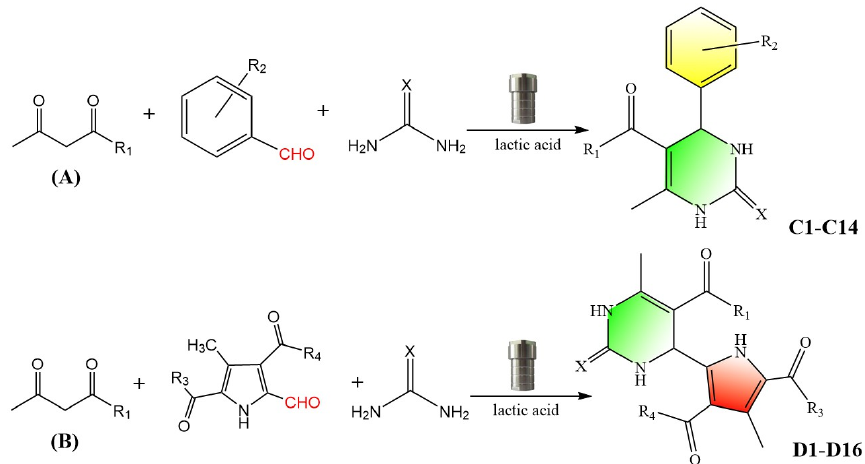
Scheme 2. Structural diversity in the DHPM scaffolds was generated by employing nine 1,3- dicarbonyl compounds, nine benzaldehyde derivatives and urea/thiourea. ( A ) Route for solvother- mal synthesis of dihydropyrimidinones containing a benzene ring ( C1 – C14 ). ( B ) Route for solvother- Table 1. Optimization of reaction conditions for solvothermal synthesis of dihydropyrimidinones ( C1 – C14 ) a .